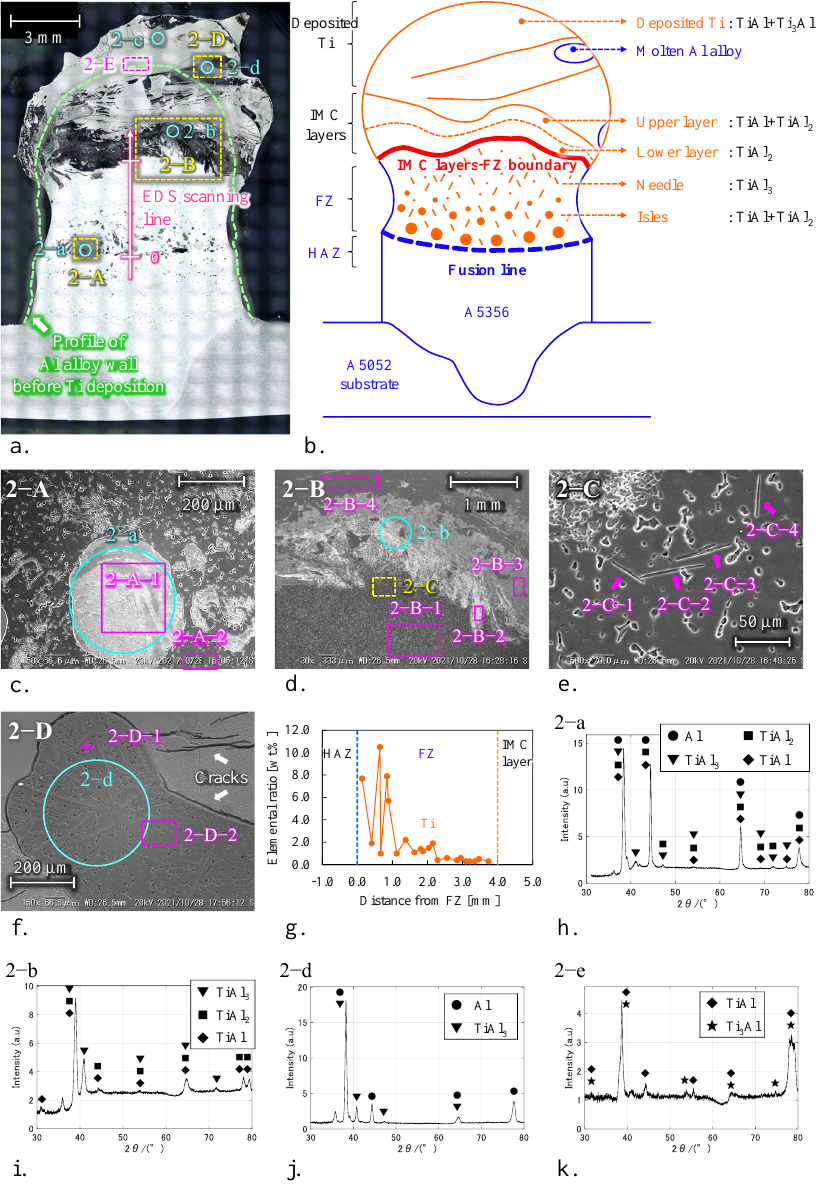
Figure 5. Ti deposited onto Al alloy wall using condition No. 9. ( a ) Overview. ( b ) Schematic diagram to illustrate the locations of the IMCs and the boundaries. ( c ) Area 2 − A: isles IMC above the boundary between FZ and HAZ. ( d ) Area 2 − B: intermetallic layers between FZ and Ti-deposited part. ( e ) Area 2 − C: needle IMC below the intermetallic layer. ( f ) Area 2 − D: molten Al alloy outside of Ti-deposited part. ( g ) Results of EDS analysis for Ti element on FZ along building direction. XRD analyses of ( h ) isles IMC on 2 − a, ( i ) Ti-side interlayer on 2 − b, ( j ) molten Al alloy on 2 − d, and ( k ) the top of Ti-deposited part on 2 −